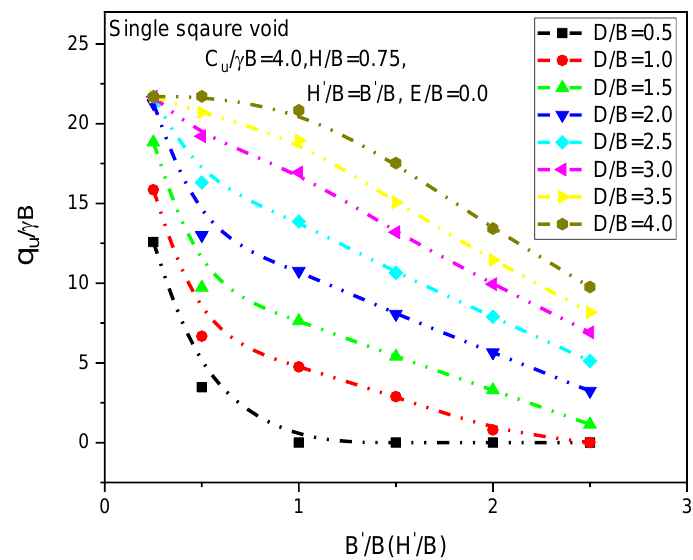
Figure 8. Effect of square void size on the ultimate bearing capacity ratio qu/γB.